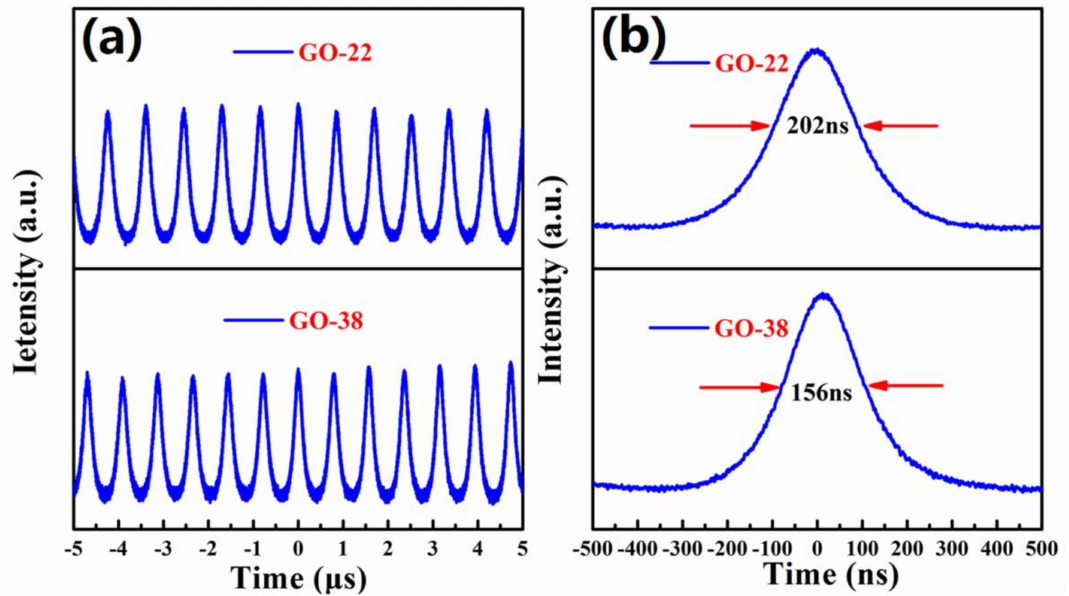
Figure 7. ( a ) Temporal pulse trains of Q-switched (QS) laser and ( b ) the single pulse profiles at 6.2 W pump power obtained with GO-22 and GO-38 SAs,